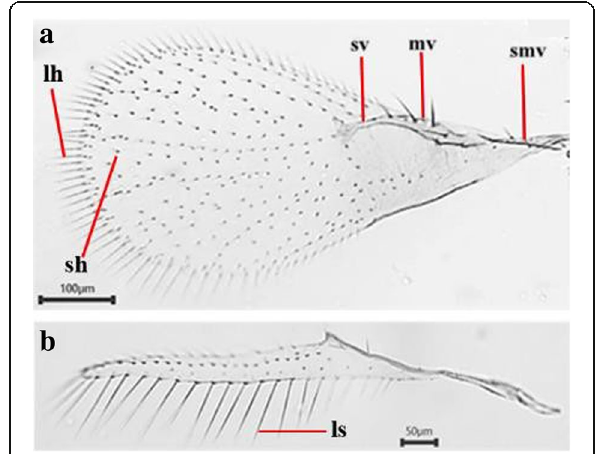
Fig. 5 Trichogramma strain TNV wings by light micrograph: a forewing (sv stigmal vein, mv marginal vein, smv submarginal vein, sh small hairs and lh longer hairs) and b hindwing ( ls long setae)